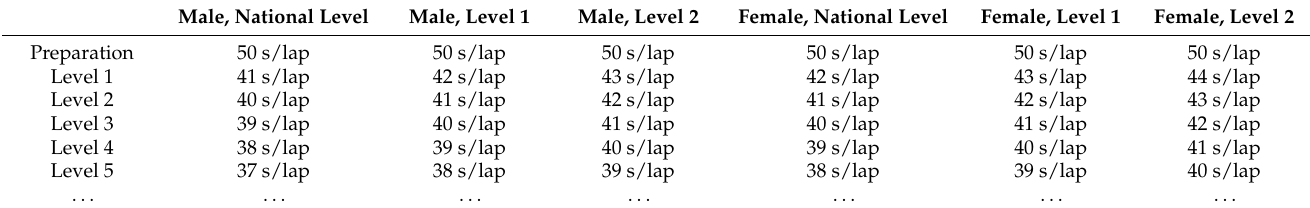
Table 3. OIST Load